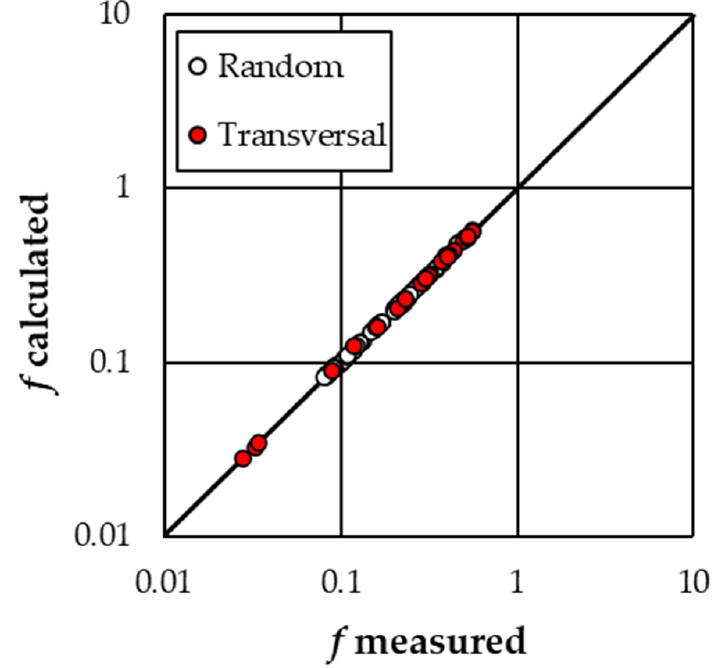
Figure 9. Comparison between the measured f values and those calculated coupling Equations (4) and (7) with b = 1.1175, c = 0.587 and a varying with the arrangement. Table 2. Values of a , b , and c coefficients obtained for the different analyses.